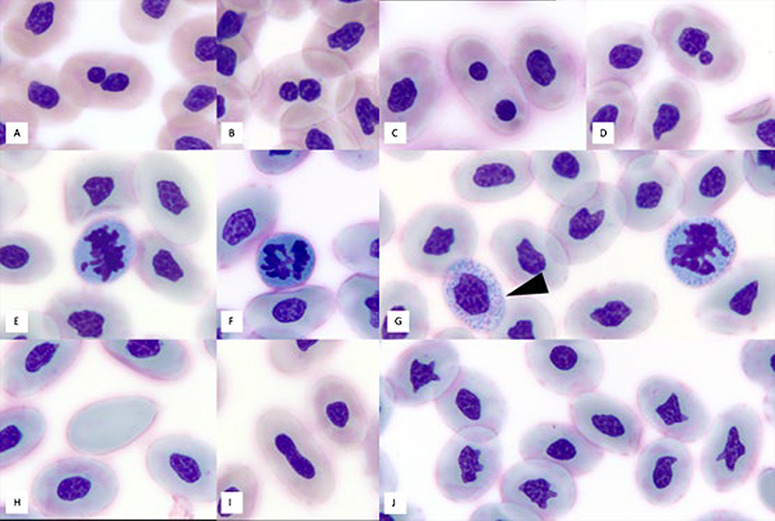
Representative images of erythrocytes in loggerhead sea turtle (C. caretta) hatchlings from Juno Beach showing binucleation (A–C), a micronucleus (D), mitotic figures (E–G), basophilic stippling (arrowhead), an erythroplastid (H) and nuclear dysplasia (I–J). ×100 objective, Wright–Giemsa stain